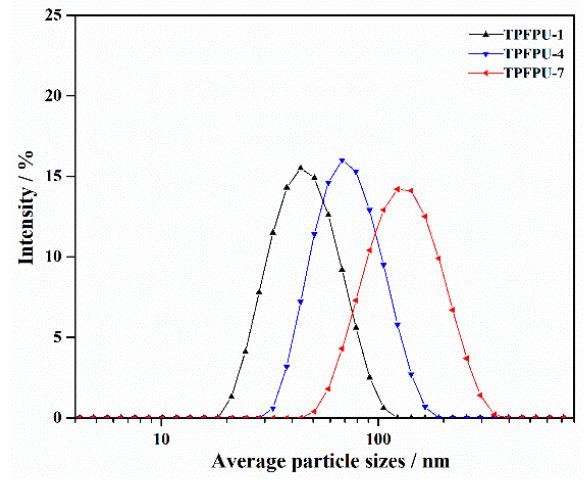
Figure 4. Particle size distribution of the TPFPUs.